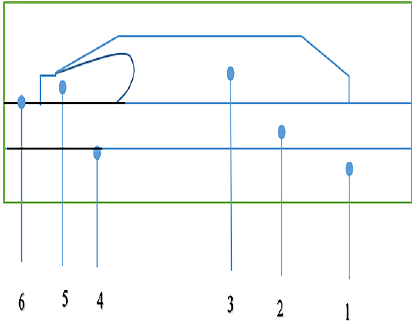
Figure 10. Cable termination model and simulation results: 1: core; 2: XLPE; 3: reinforced insulation; 4: inner shield; 5: stress cone; 6: outer shield.